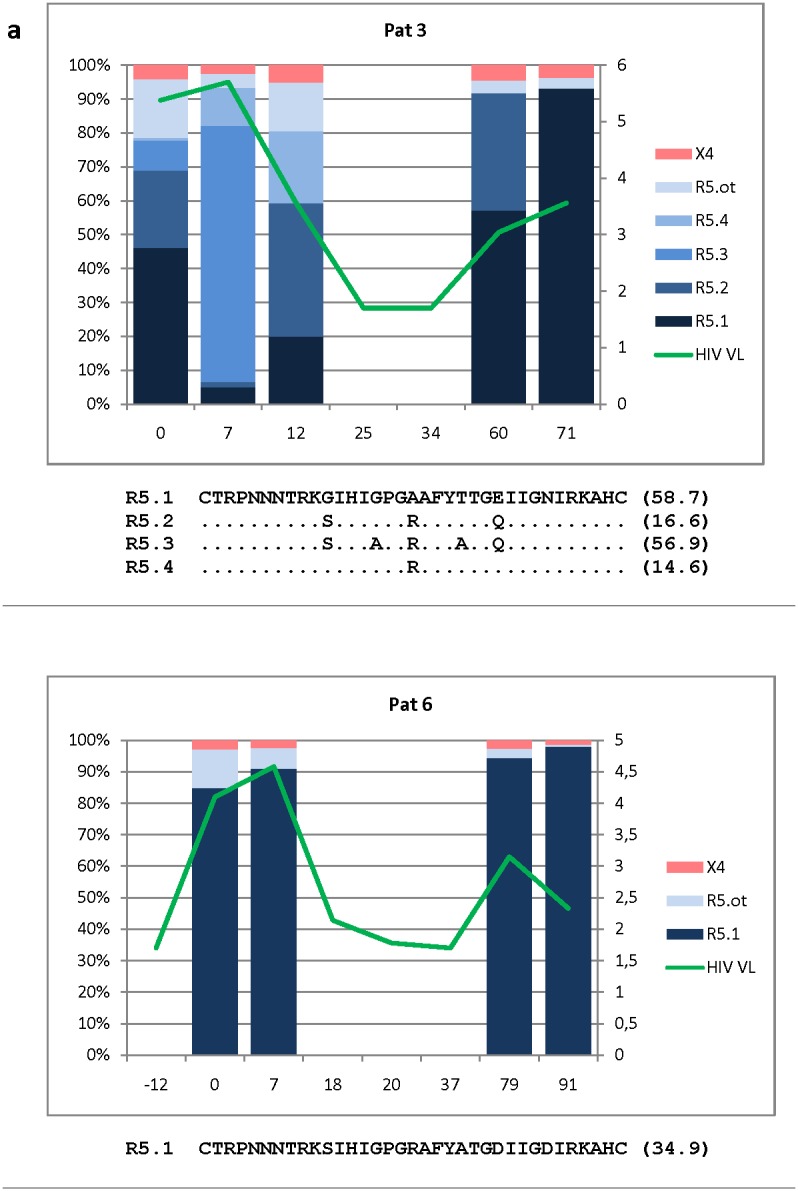
Intra-patient relative abundance of R5 and X4-using variants identified over time.Longitudinal analysis of the relative abundance (y left axis: percentage) of R5 (blue range) and X4 (red range) variants at different time points (x axis: sampling times in months). At the first sampling time, the most abundant variant is identified by darker color and named as “R5.1” or “X4.1”, accordingly. Colors become clearer according to the decrease in their relative abundance. “R5.ot” and “X4.ot” include those viral variants with very low relative abundance. For subsequent sampling times, the color palette is respected following the first one in order to allow correlating the longitudinal variation of the viral variants first identified. HIV viral load are represented (y right axis; as log copies/ml). The V3 amino acid sequence (and between brackets, their relative false positive rate by geno2pheno) of the most common variants in each patient is shown.